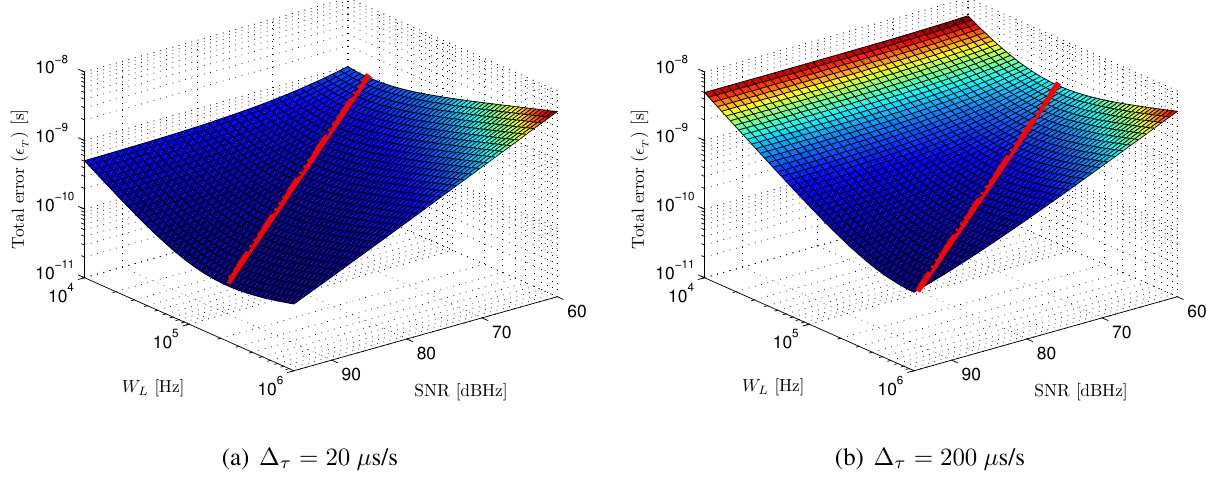
Figure 6. Total error and total minimum error (red line) as a function of input SNR and loop ) for two different delay rates of change (∆ bandwidth ( W L